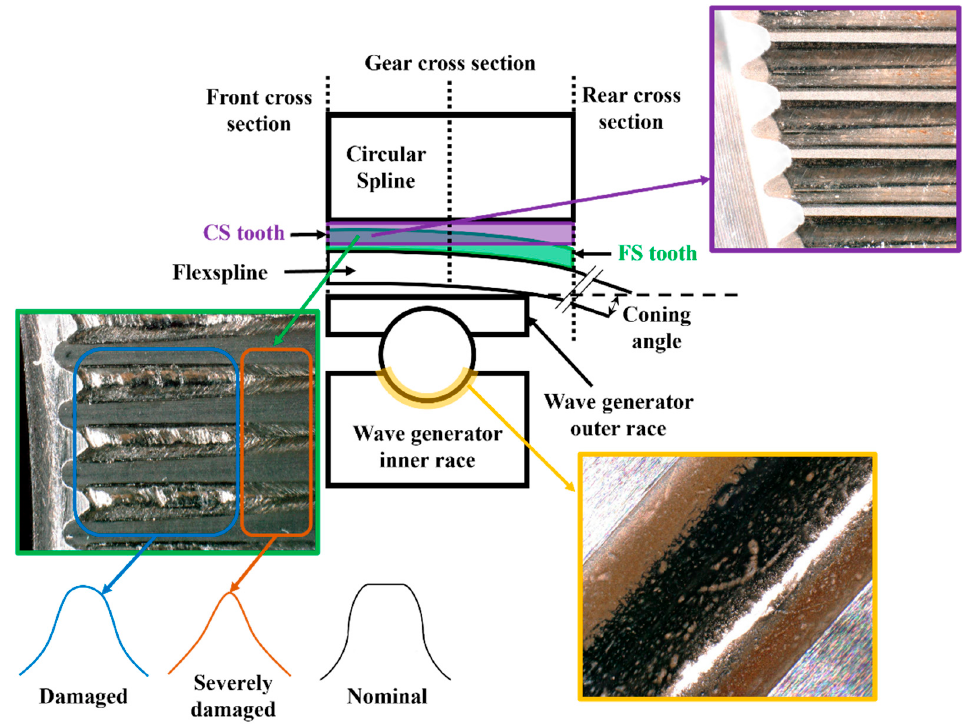
Figure 4. ( a ) Pitting on the flexspline teeth of gear A. ( b ) Adhesive wear marks on the wave generator and the flexspline of gear A.